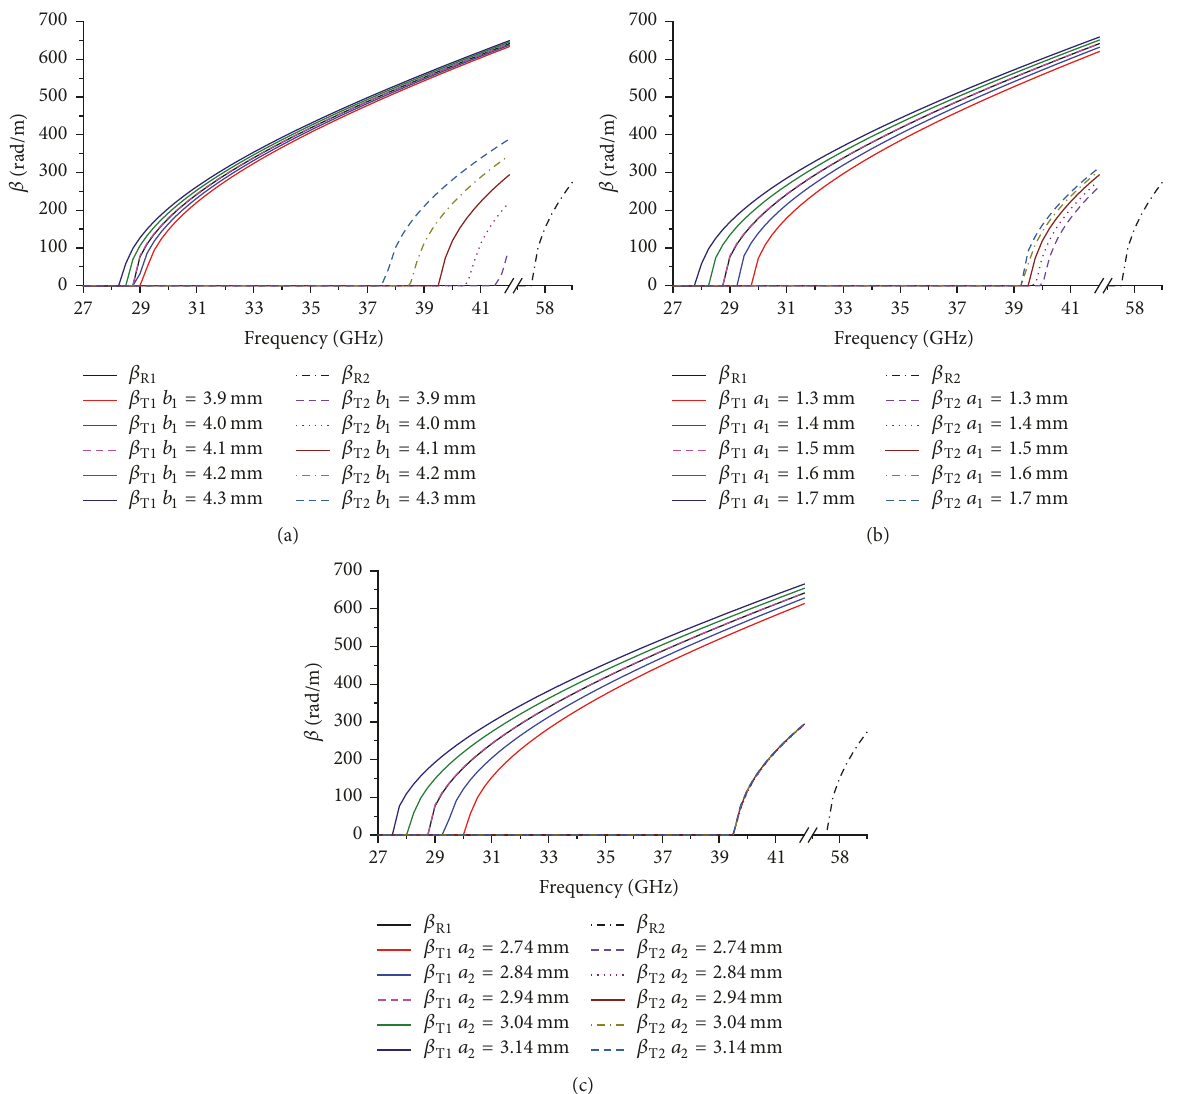
Figure 2: The propagation constant curves of rectangular waveguide and T-shaped waveguide versus frequency in dominant mode and second higher mode versus (a) 𝑏 1 , (b) 𝑎 1 , and (c) 𝑎 2 .